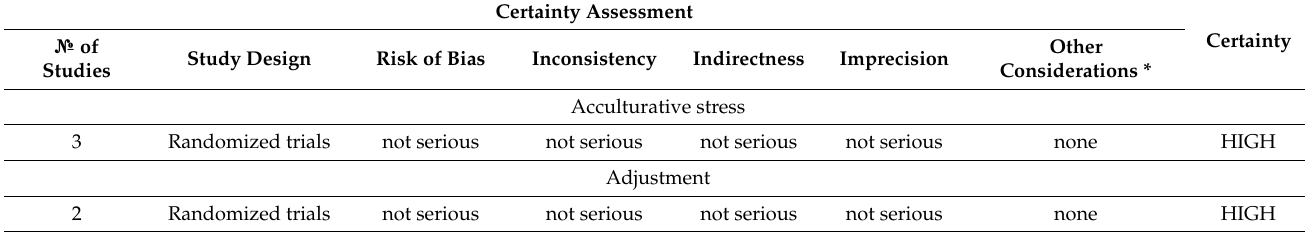
Figure 6. Funnel plots of the publication bias of pooled evidence from a meta-analysis. ( a ) Funnel plot of evidence of acculturative stress before application of the sensitivity test, ( b ) funnel plot of evidence of acculturative stress after application of the sensitivity test, ( c ) funnel plot of evidence of adjustment before application of the sensitivity test, ( d ) funnel plot of evidence of adjustment after application of the sensitivity test. Table 3. Assessment of pooled evidence from meta-analysis after application of sensitivity